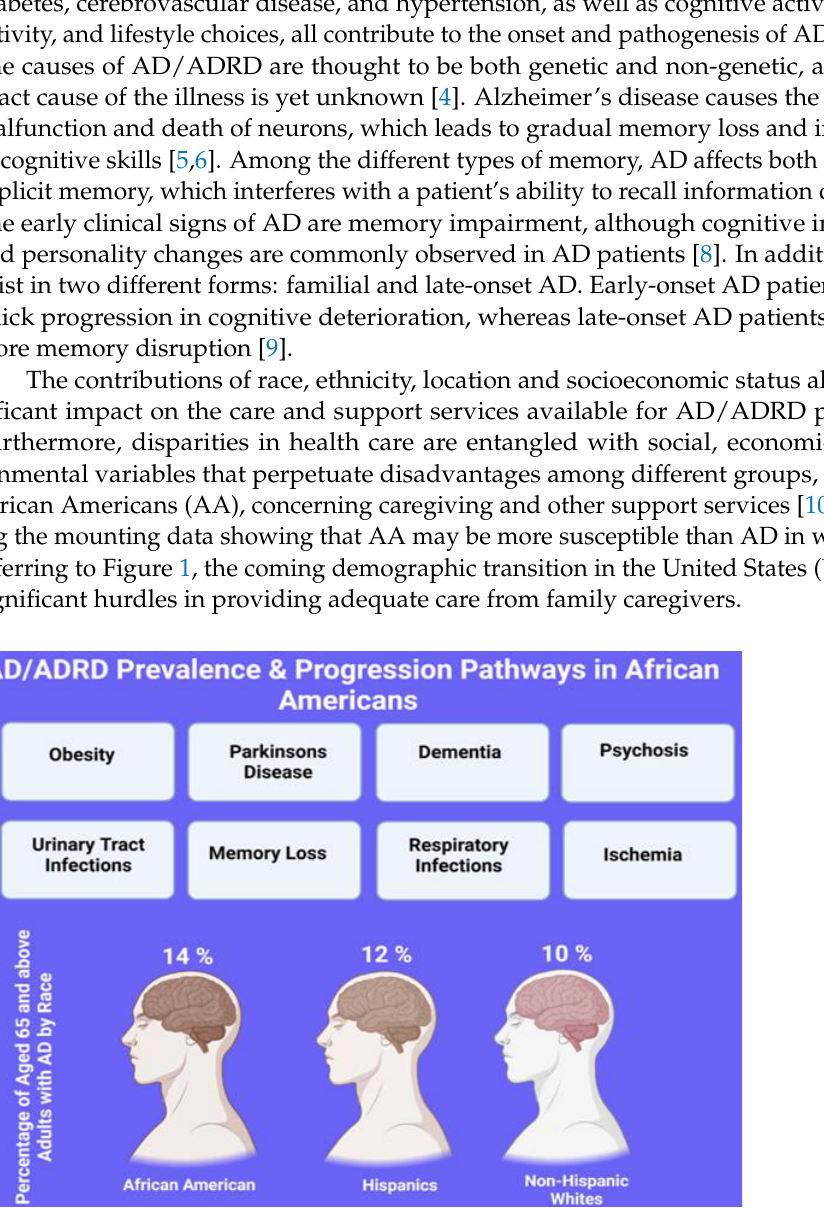
Figure 1. Prevalence and progression pathways of Alzheimer’s disease and related dementias in African Americans.